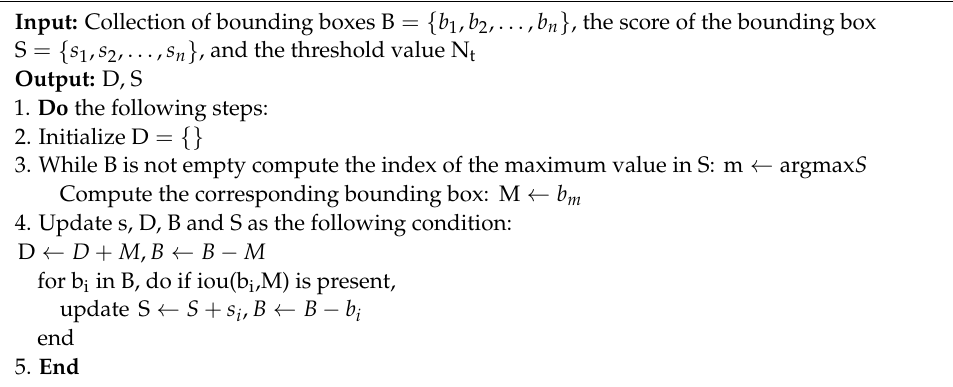
Algorithm 6 Improved NMS